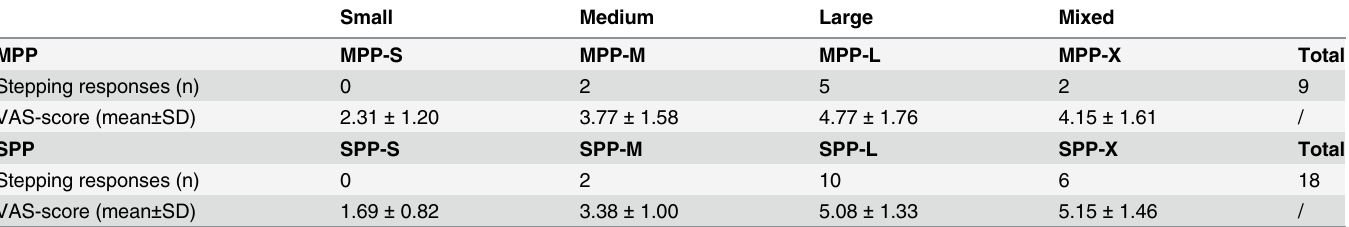
Table 2. The amount of stepping responses that were monitored in the different conditions are visualized in this table as well as the average visual analogue scale (VAS) score relating to the difficulty level to control the different external